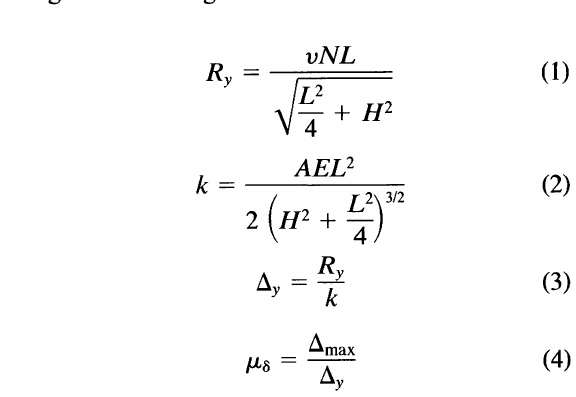
FIGURE 1 Braced building frame with ASBD.